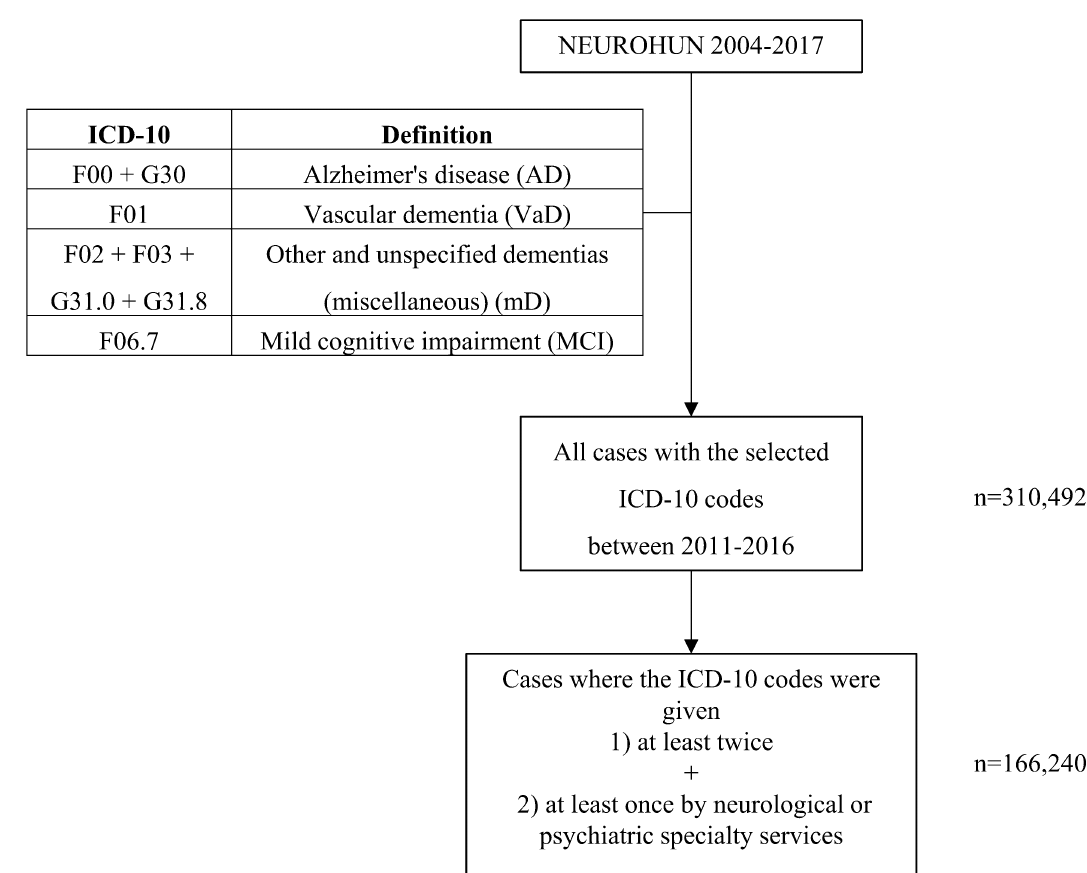
Figure 1. Flowchart of patient selection and the classification of subtypes of dementia (with their abbreviations) used in our study with their corresponding ICD-10